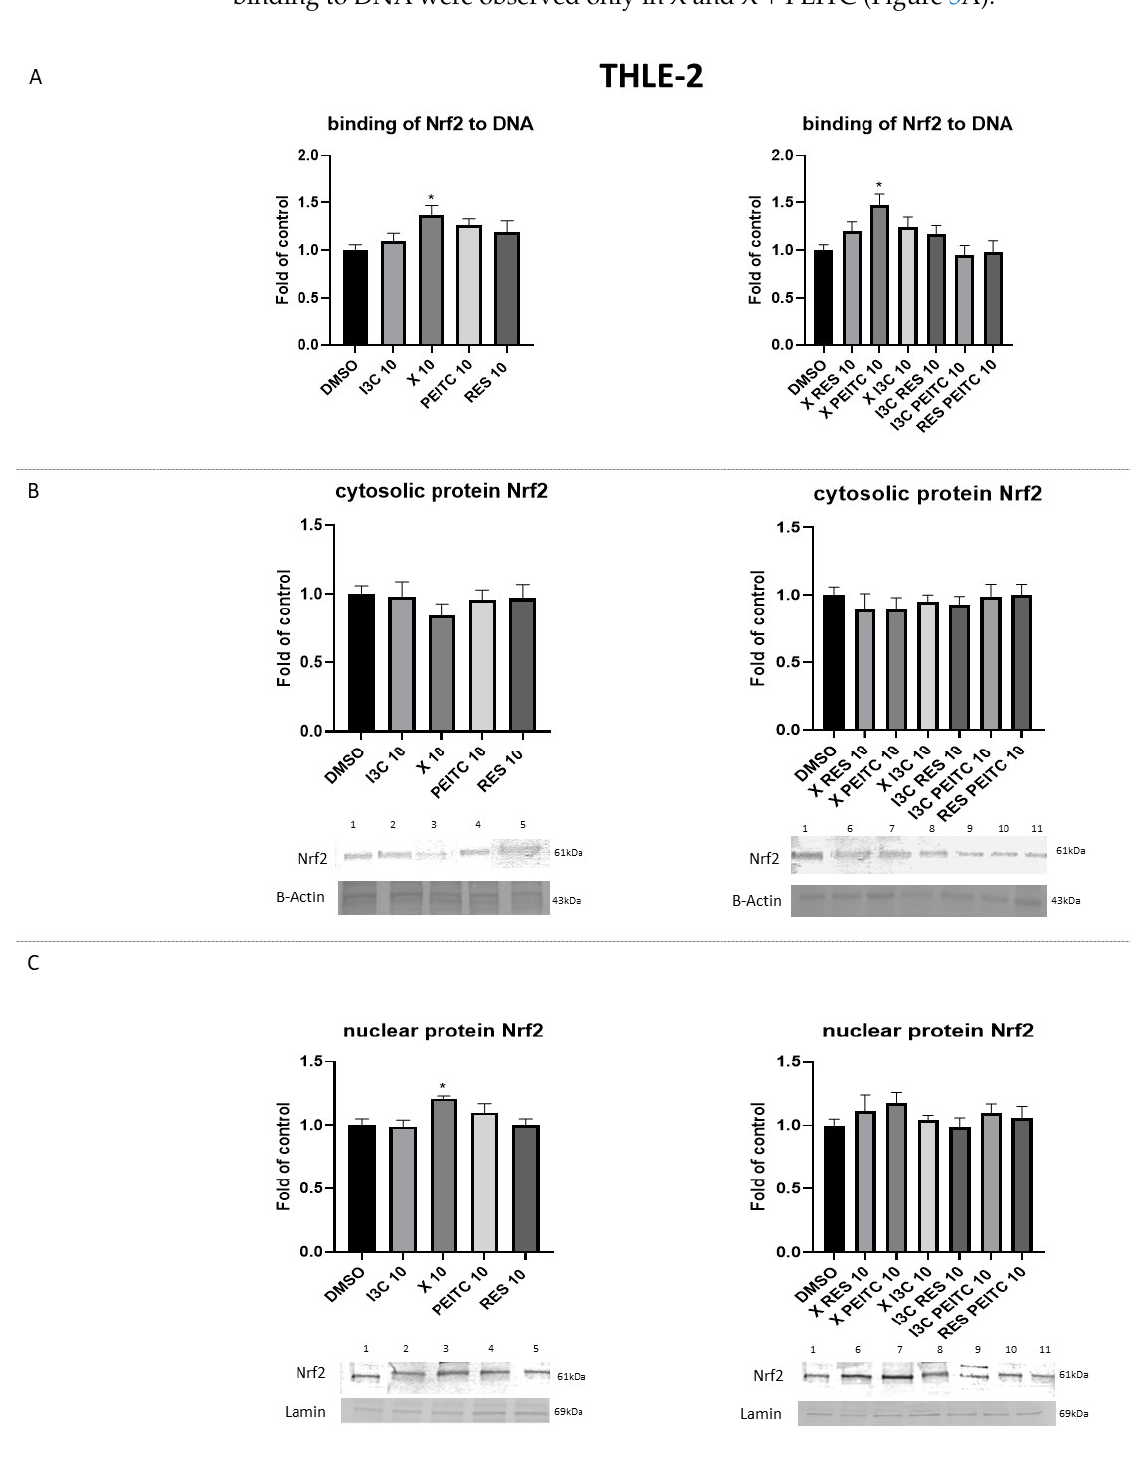
Figure 5. The impact of X, PEITC, RES, I3C, and their mixtures on the activation of Nrf2 in THLE-2 cells. Panel ( A ) The activation of Nrf2 was estimated in terms of the amount of Nrf2 contained in the DNA-binding complexes extracted